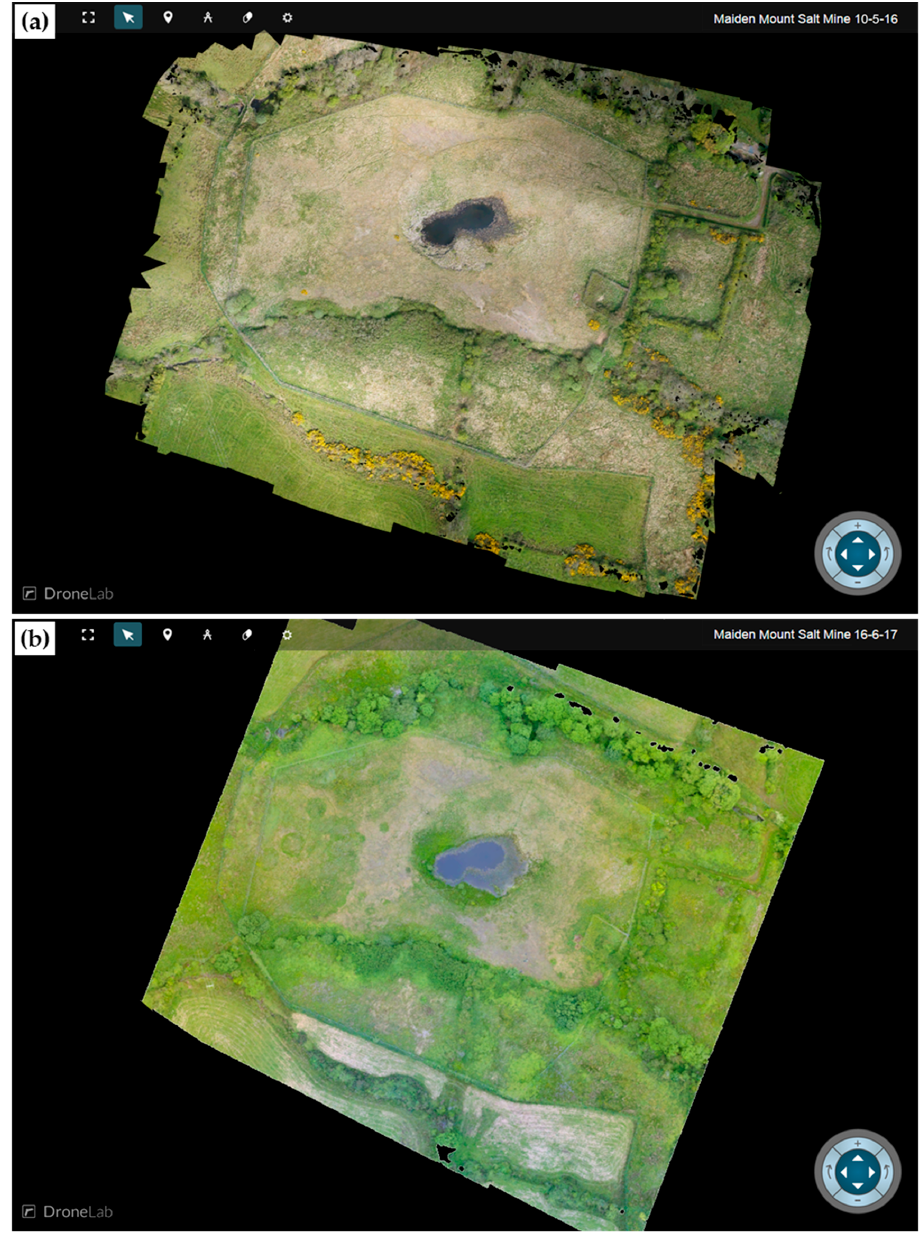
Figure A2. SUAV-derived VHR ortho-photographs of the Maiden Mount salt mine collapse at Carrickfergus, UK, based on the ( a ) 2016 and ( b ) 2017 campaigns and made available via DroneLab.